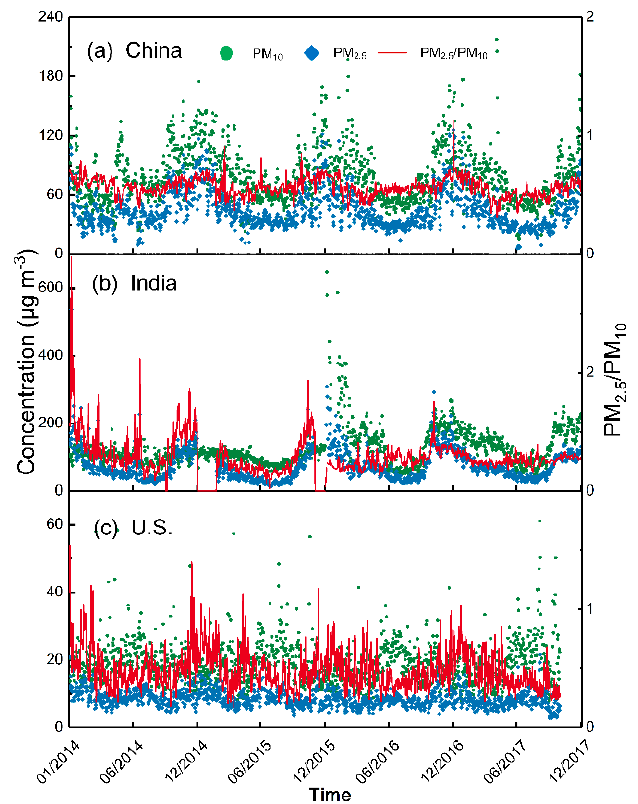
Figure 6. Daily concentrations and ratios of PM 2.5 and PM 10 in ( a ) China, ( b ) India and the ( c ) U.S. throughout the four years.